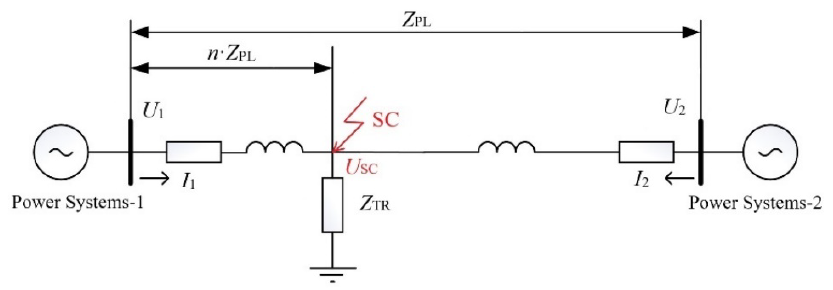
Figure 1. Simplified single-line diagram of PL in case of a short circuit through transient resistance.